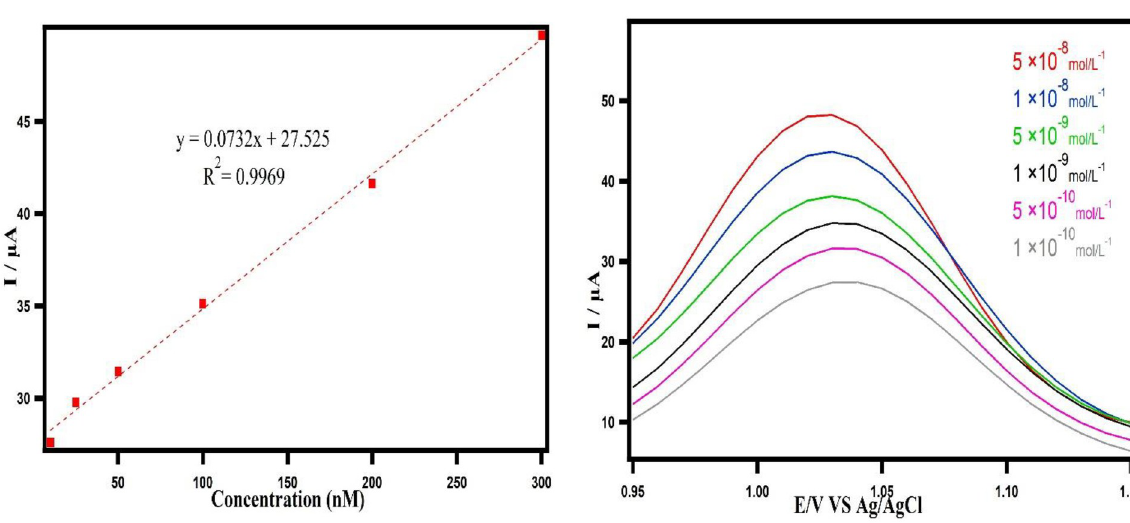
Fig 6. Calibration curve plotted for voltametric determination of CBZ by using MWNTs/MIP/CP sensor.